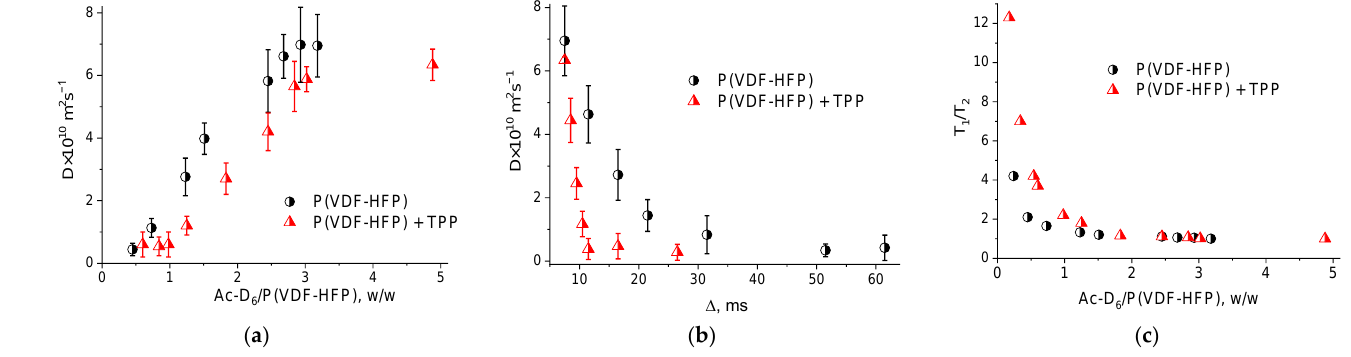
< x 2 > for a pure polymer solution is greater than for a polymer with TPP.